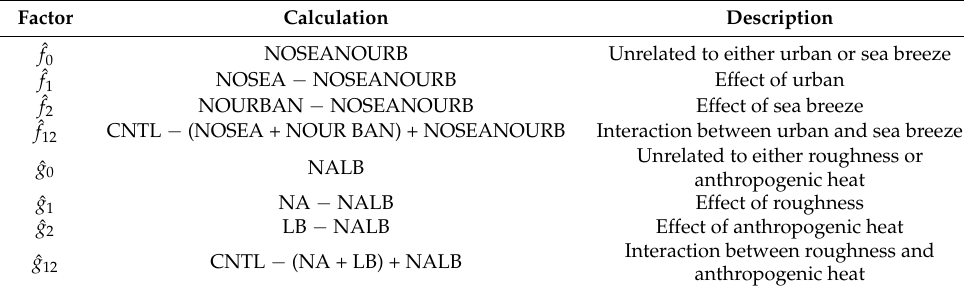
Table 3. Calculation of factor